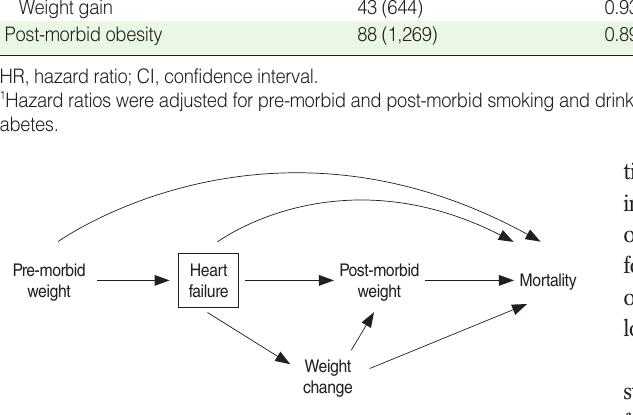
Figure 2. Directed acyclic graph representing weight change due to disease as a confounder for the relationship between post-mor- bid weight and